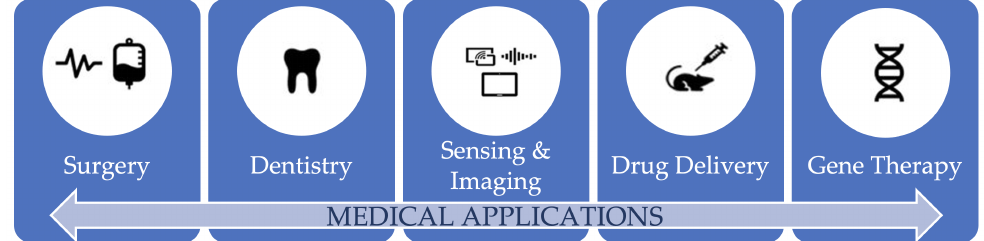
Figure 5. Medical applications of